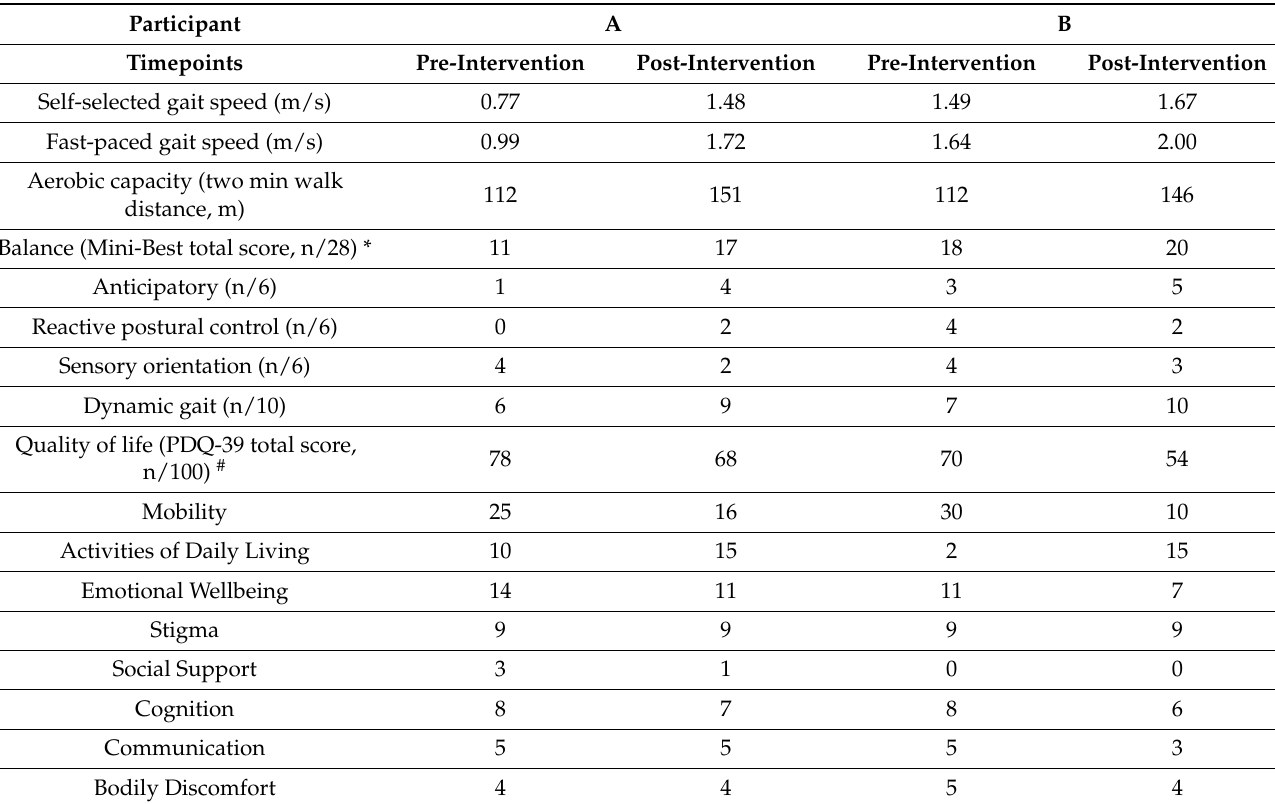
Table 2. Responses to the BDJ telerehabilitation